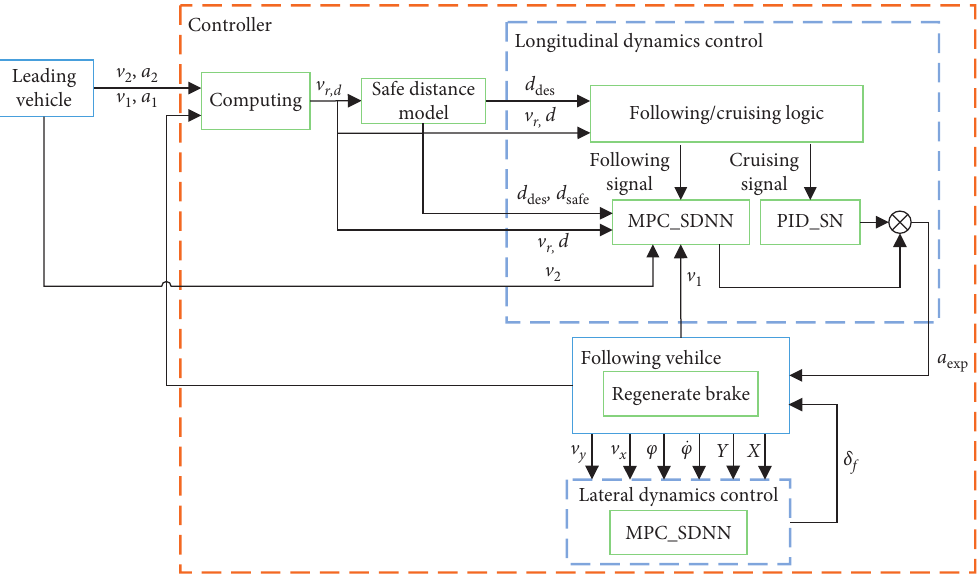
Figure 9: Flowchart of the proposed ACC system. Table 7: Values of the parameters in the vehicle longitudinal Table 8: Values of the parameters of the vehicle model. dynamics and longitudinal dynamics controller design.